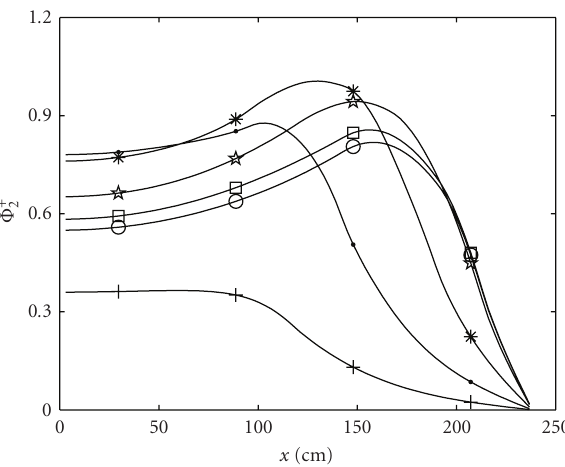
Figure 8: Graphs of the neutron importance for the second group.